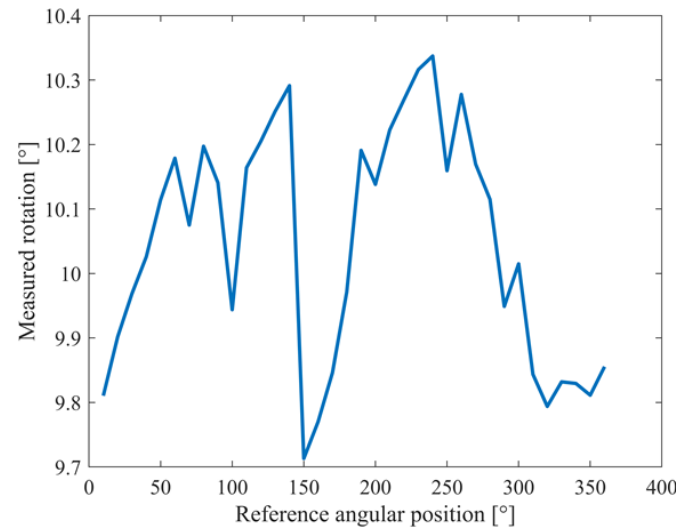
Figure 8. Measured rotations for different angular positions. Table 2. Mean measured values in the presence of nominal rotations equal to 10°.